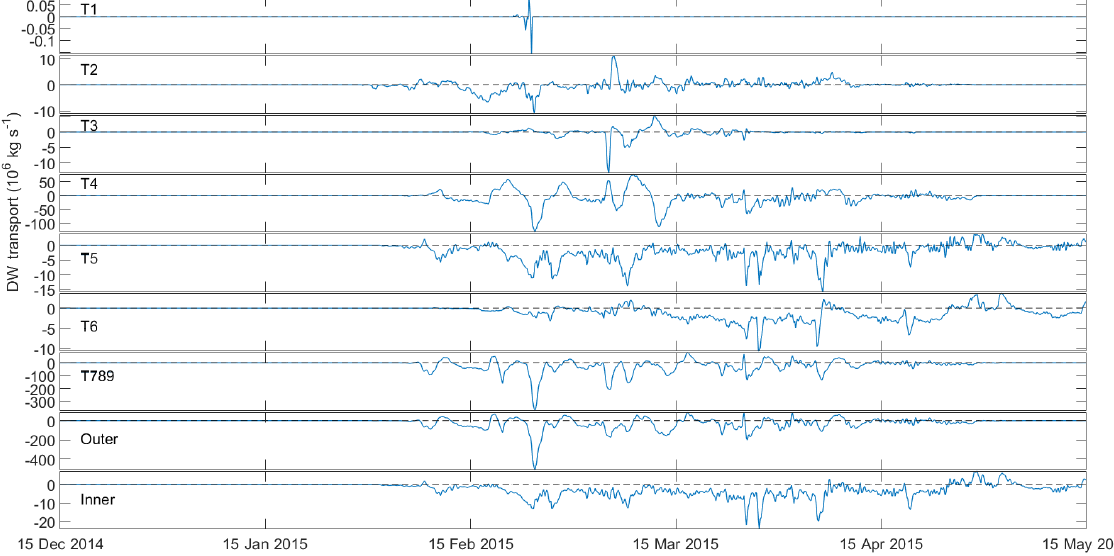
Figure 16. As in Fig. 14, but for dense-water mass transports.